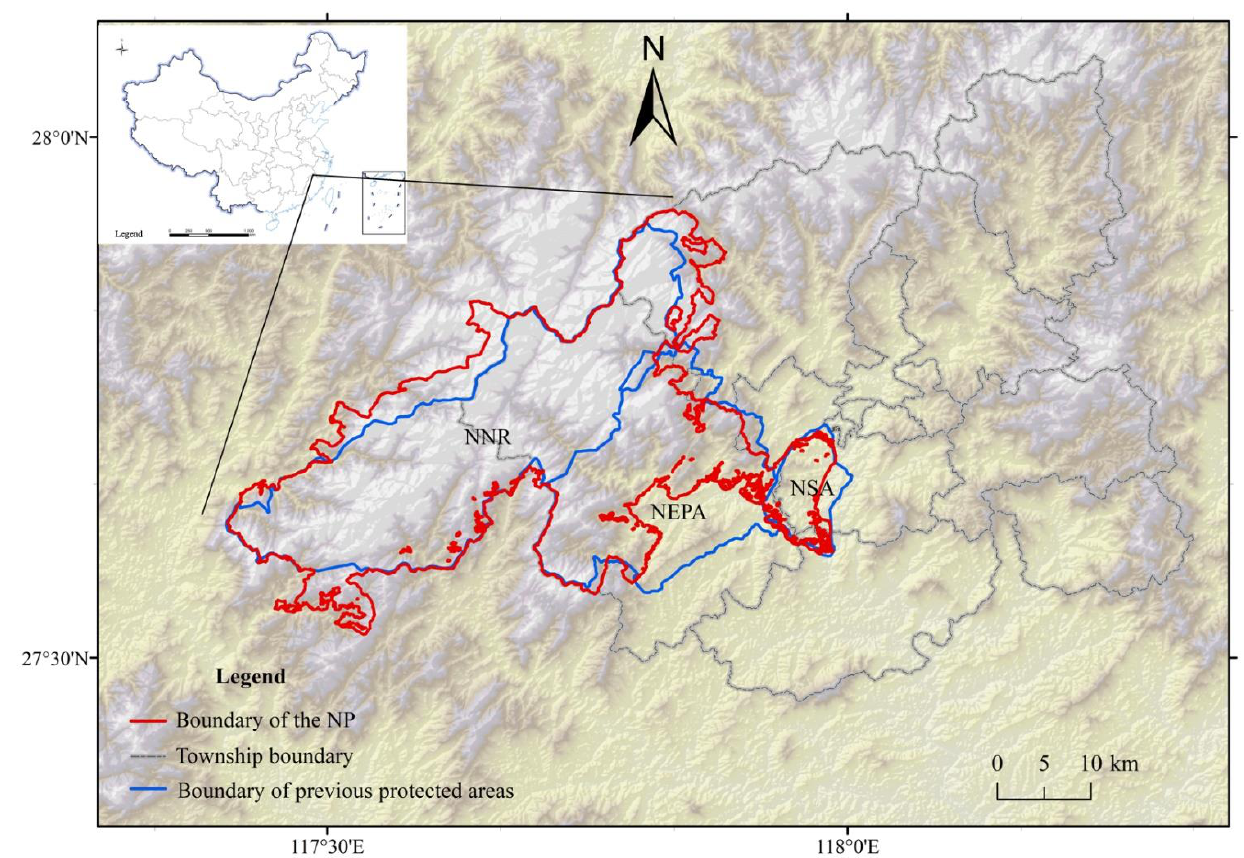
Figure 1. Location and composition of the Wuyishan National Park, the Wuyishan National Scenic Area (NSA), the Wuyishan National Nature Reserve (NNR), and the Upstream Ecological Protection Area of the Nine Bend River (NEPA).